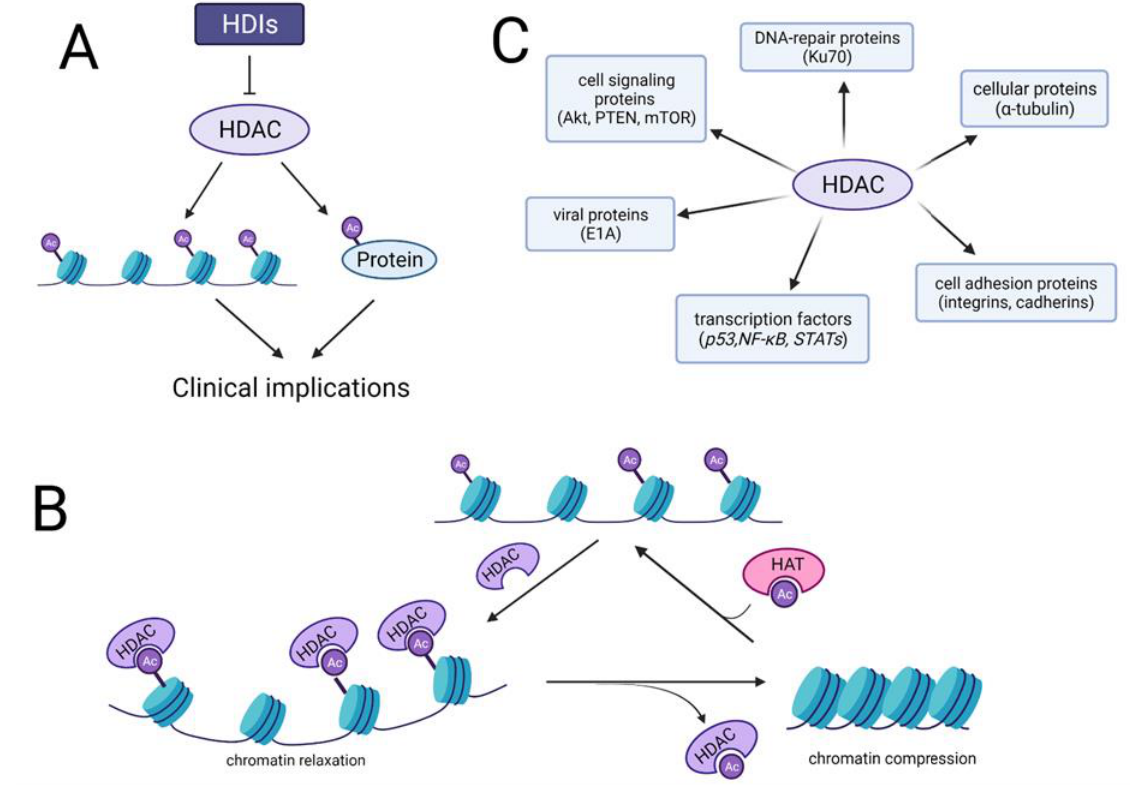
Figure 1. ( A ) Histone deacetylase inhibitors (HDIs) block HDACs expression leading to upregulation of acetylation histone and non-histone protein what resulted in clinical implications. ( B ) Reversible posttranslational lysine residues acetylation of histones is maintained by HATs and HDACs. Removal of acetyl group by HDACs leads to condensation of chromatin and its inactivation. ( C ) The multiple roles of HDAC enzymes in cells. Regulation of non-histone proteins (transcription factors, adhesion proteins, cellular proteins, DNA-repair proteins, cell signaling and viral proteins) according to their acetylation state, which indicates that HDACs can influence a multitude of physiological pathways in different cells.